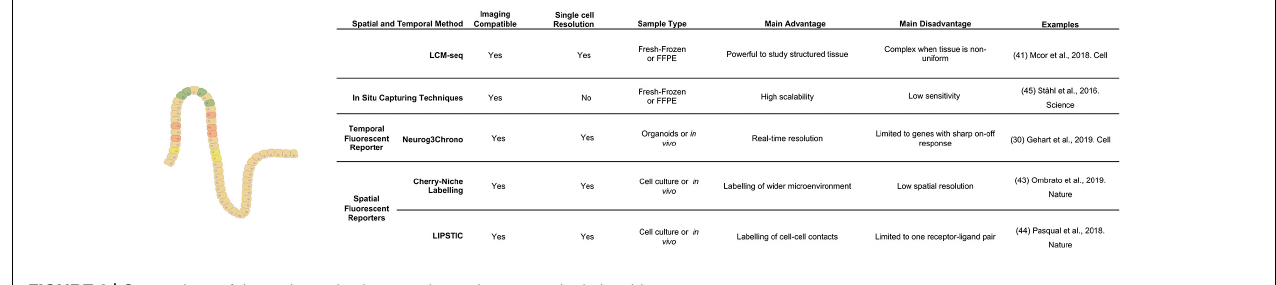
FIGURE 3 | Comparison of the main methods to study spatio-temporal